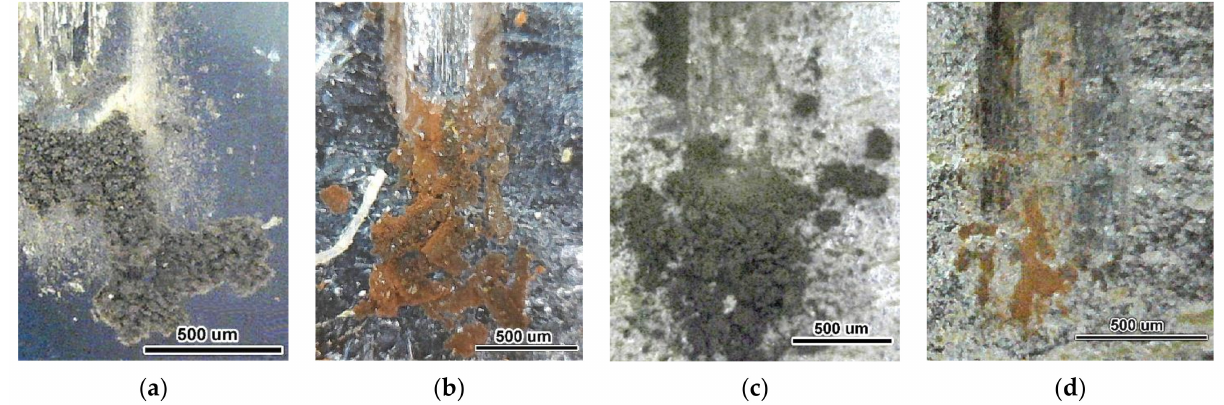
Figure 14. Optical micrographs of the wear debris for different sliding couples: ( a ) 100Cr6-substrate (steel of AISI 4145H grade), ( b ) SiC-substrate (steel of AISI 4145H grade), ( c ) 100Cr6-coating, ( d ) SiC-coating.